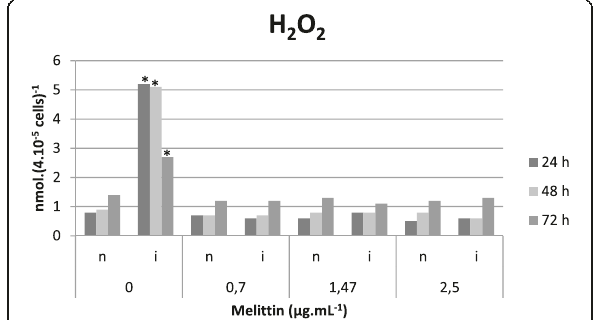
Fig. 4 Determination of IL-10 concentration (pg.mL − 1 ) in the supernatant of uninfected macrophages ( n ) and infected macrophages ( i ) after melittin treatment (0, 0.7, 1.47 and 2.5 μ g.mL − 1 ) at 24, 48 and 72 h. Data are presented as mean of three independent measurements. ● p < 0.05, for 48 and 72 h treatment with 2.5 μ g.mL − 1 melittin versus non-infected cells. Δ p < 0.05 for 24 h treatment with 2.5 μ g.mL − 1 melittin versus non-infected non-treated cells. All treated infected cells (24, 48 and 72 h; 0, 0.7, 1.47 and 2.5 μ g.mL − 1 ) were statistically different ( p < 0.05) of the corresponding non-treated cells